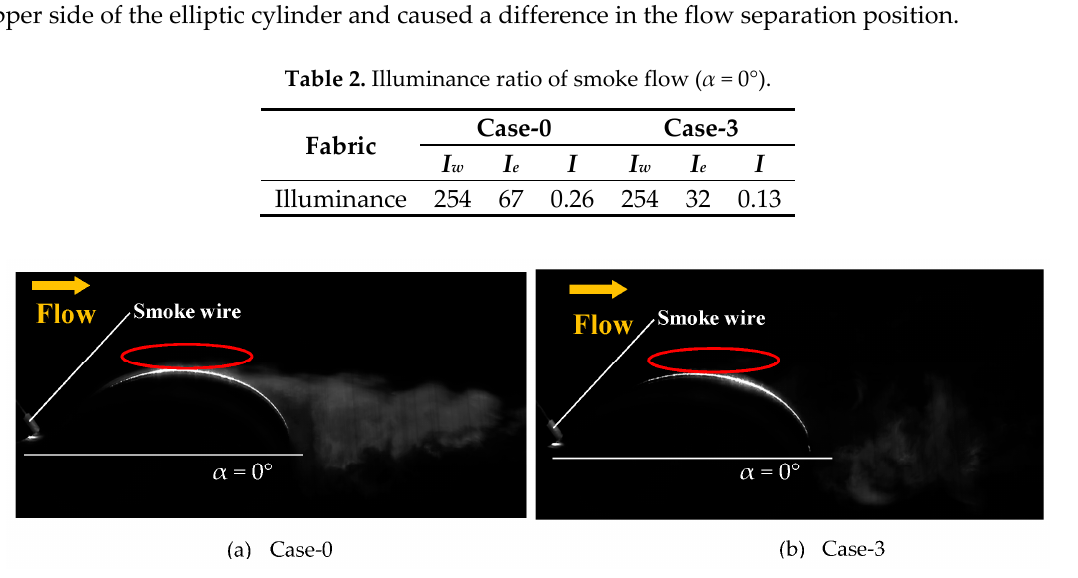
Figure 9. Smoke-wire flow visualization around test model ( α = 0°, Re = 1.0 × 10 5